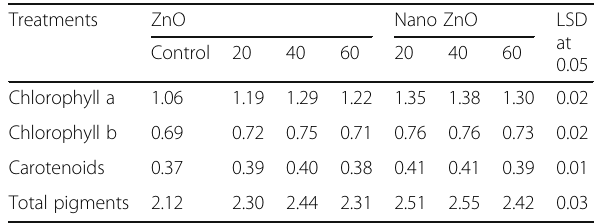
Table 9 Effect of ZnO or nano ZnO different concentrations on photosynthetic pigments ( μ g/g fresh wt) of flax leaves under sandy